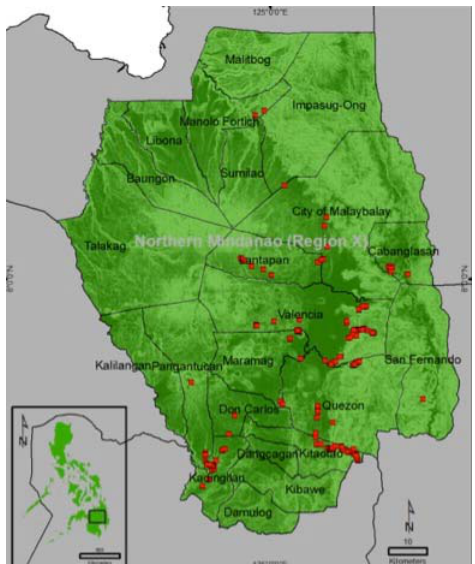
Fig. 5: Actual distribution of Piper aduncum L. in Bukidnon province